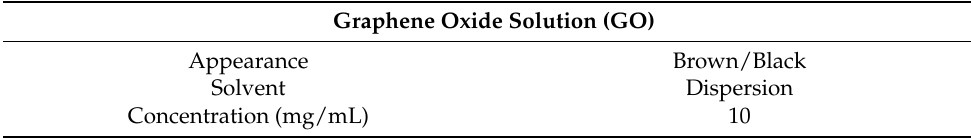
Table 2. Properties of graphene oxide